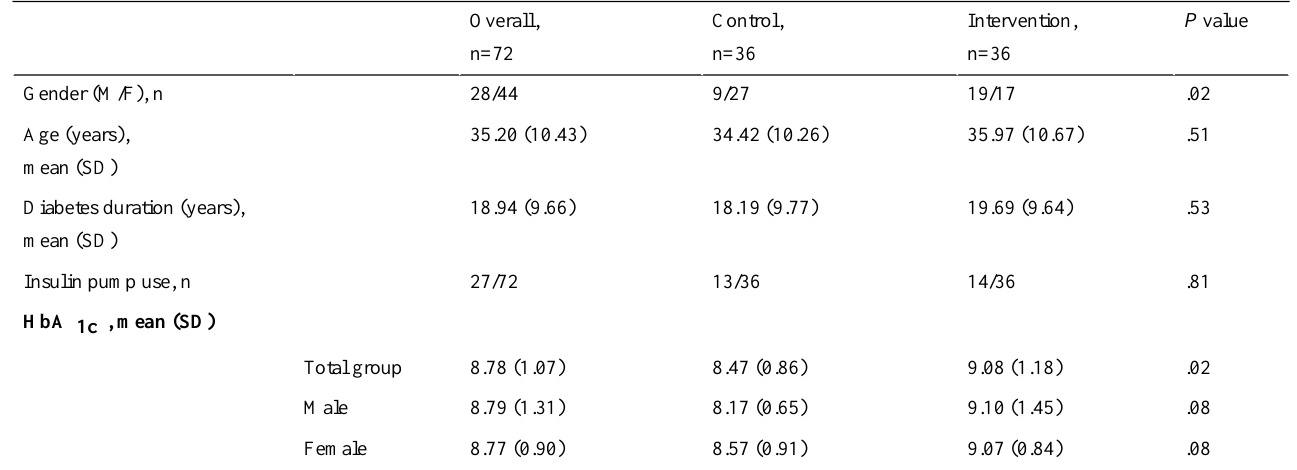
Table 1. Participant characteristics at baseline.